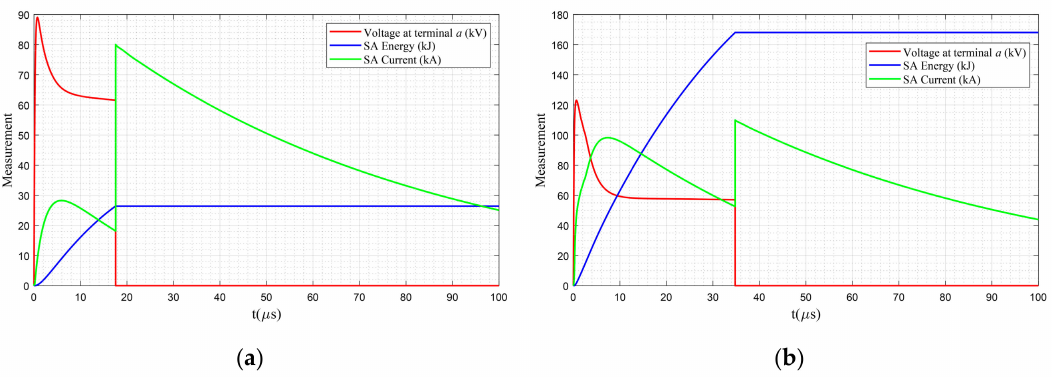
Figure 13. Failure of ( a ) SA-24a under 100 kV lightning impulse and ( b ) SA-24b under 175 kV lightning impulse.